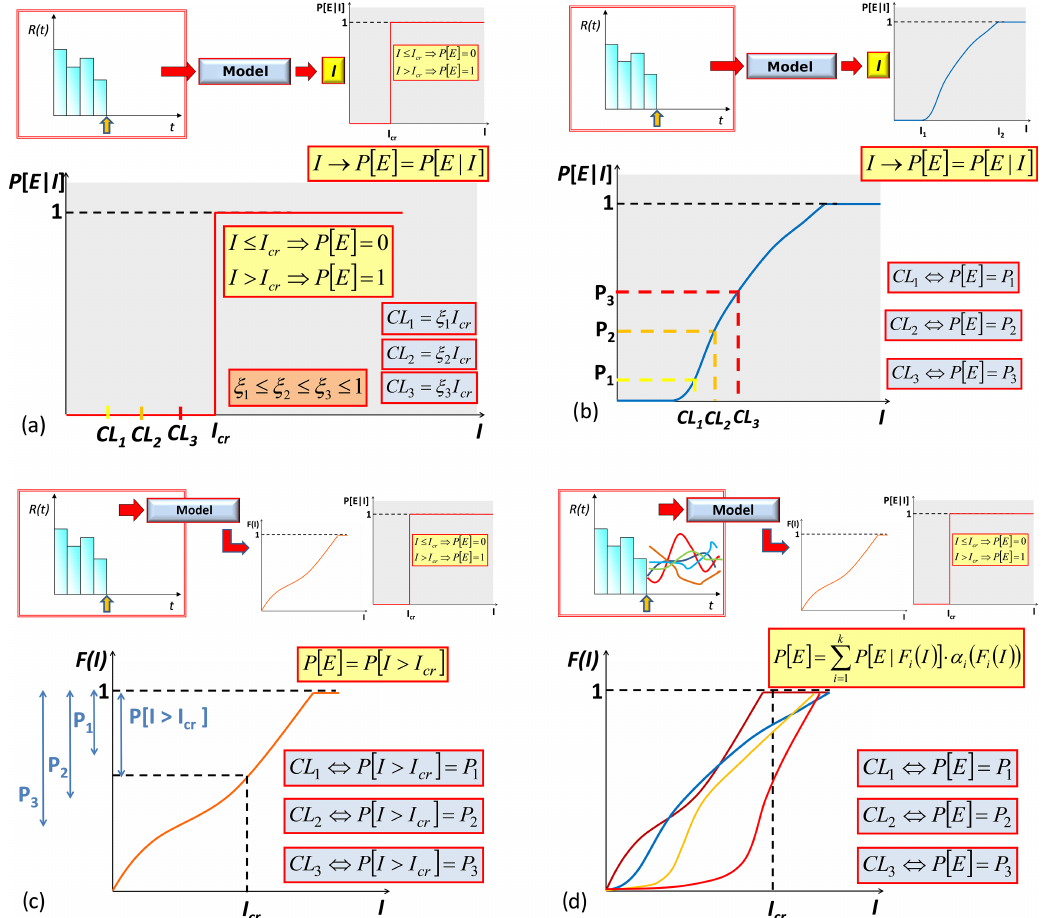
Figure 2. Examples of rainfall thresholds. (a) Scheme A: use of only rainfall data observed in real time, model providing a deterministic value for I , adoption of a step function for P [ E | I ] . (b) Scheme B: use of only rainfall data observed in real time, model providing a deterministic value for I , adoption of a generic monotonic non-decreasing function for P [ E | I ] . (c) Scheme C: use of only rainfall data observed in real time, model providing a probability distribution for I , adoption of a step function for P [ E | I ] . (d) Scheme D: use of rainfall predictions together with rainfall height observed in real time, model providing a probability distribution function for I , adoption of a step function for P [ E | I ]